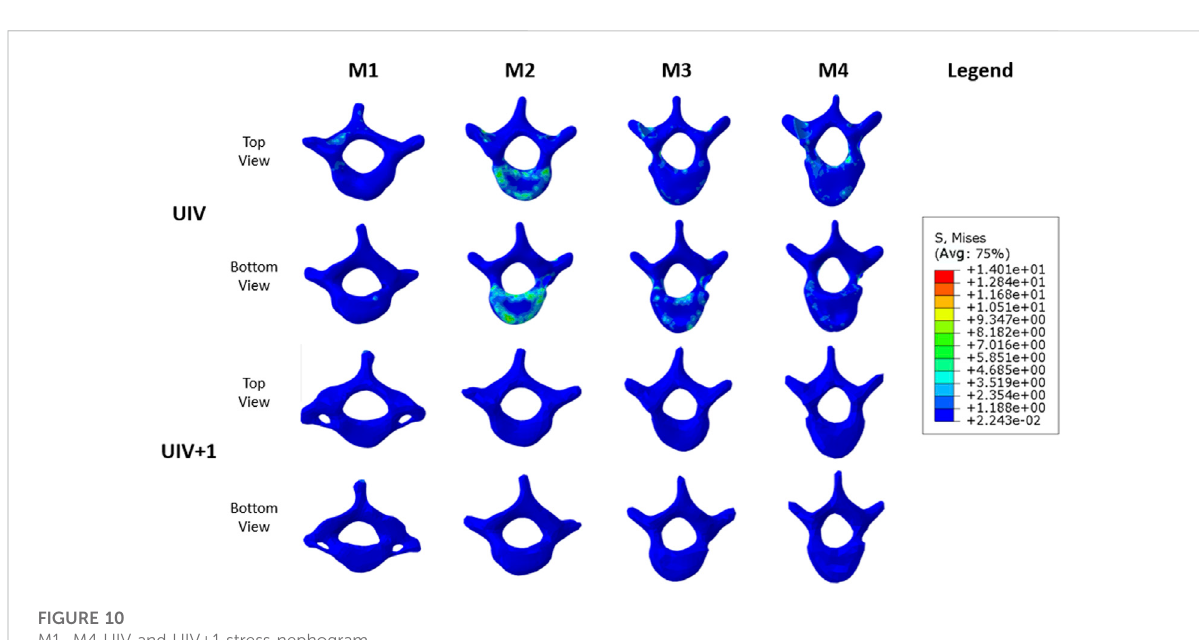
FIGURE 10 M1 – M4 UIV and UIV+1 stress nephogram.